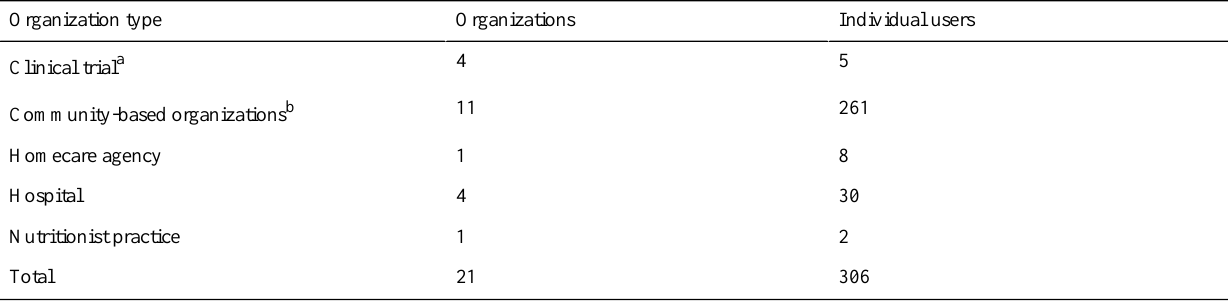
Table 1. Organizational characteristics of Sense Health users.